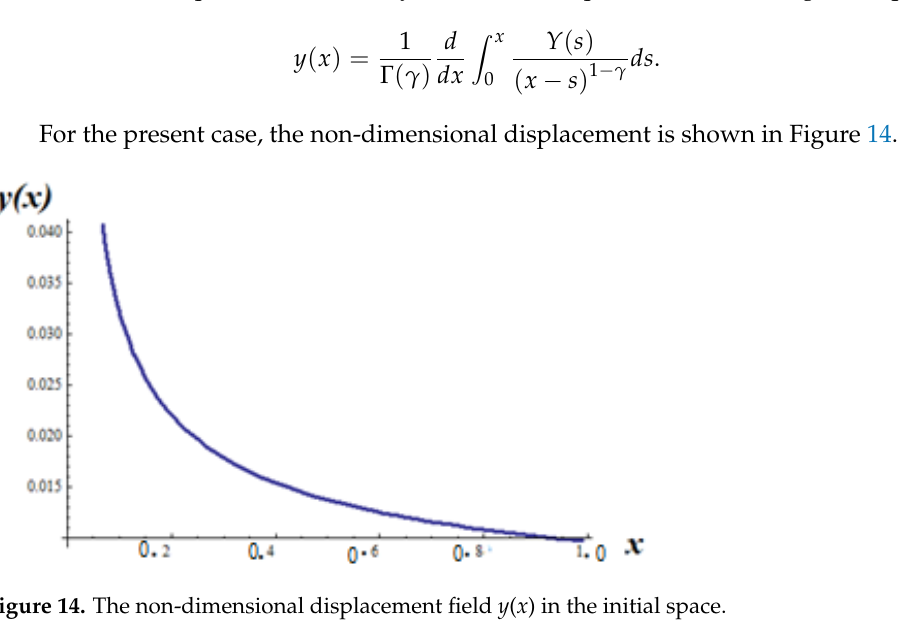
Figure 14. The non-dimensional displacement field y ( x ) in the initial space.